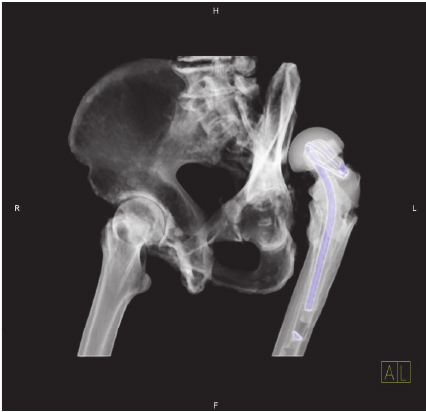
Figure 1: CT scan showing bilateral first-stage revision THR prostheses with right-sided pelvic discontinuity and a severe left- sided posterosuperior acetabular deficiency.